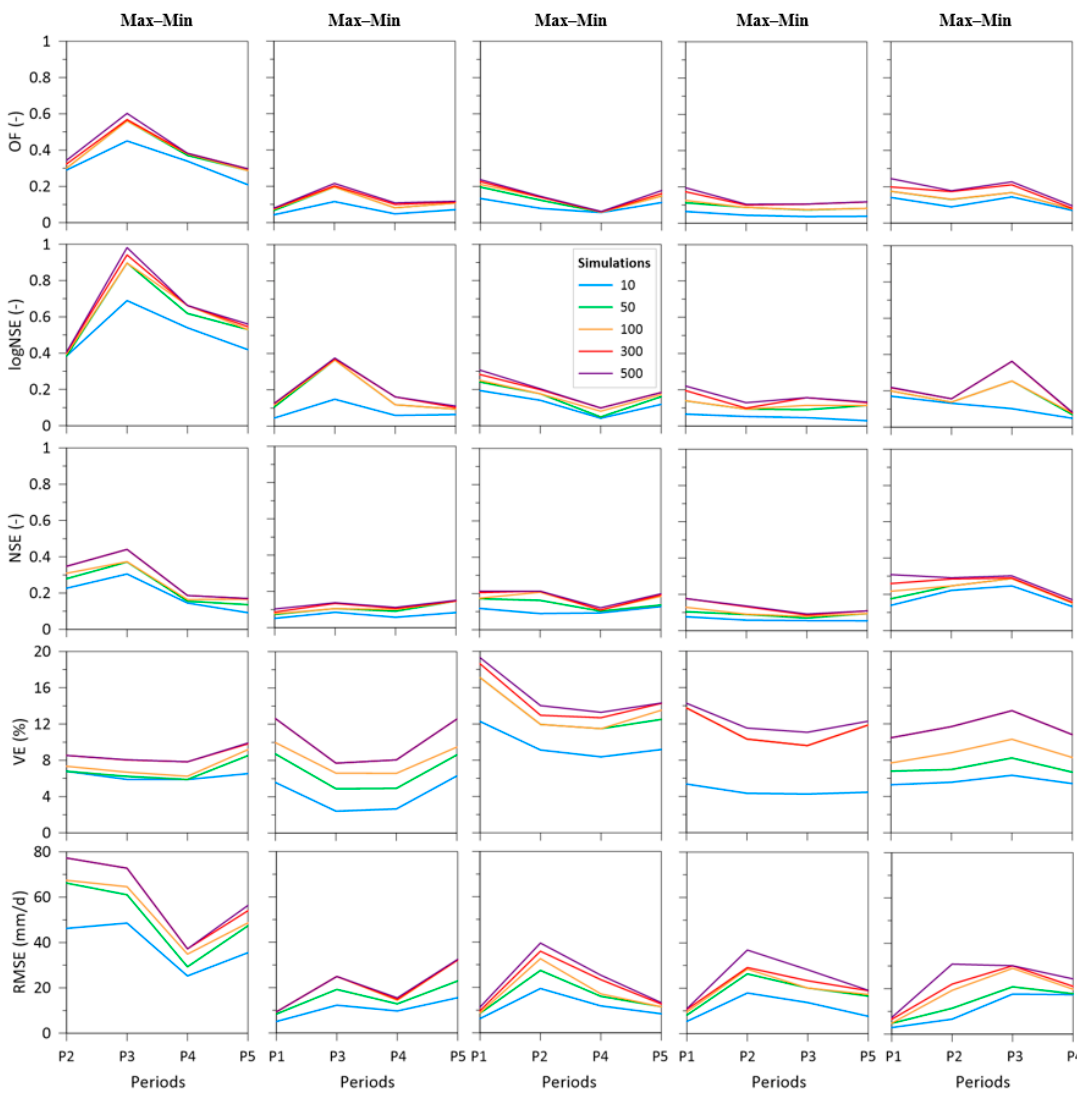
Figure 5. Variability of the ranges of the objective function (OF), the logarithmic Nash-Sutcliffe efficiency (logNSE), the Nash-Sutcliffe efficiency (NSE) criteria, the root mean square error (RMSE) and the volume error (VE) after 10, 50, 100, 300, 500 repetitions of model simulations in four validation periods. The lines represent the ranges (Max–Min) of different metrics obtained by the different number of repetitions.